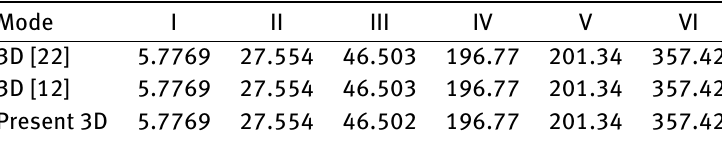
Table 1: First assessment for the 3D exact solution, simply supported plate made of aluminium alloy with thickness ratio a/h=10. First six